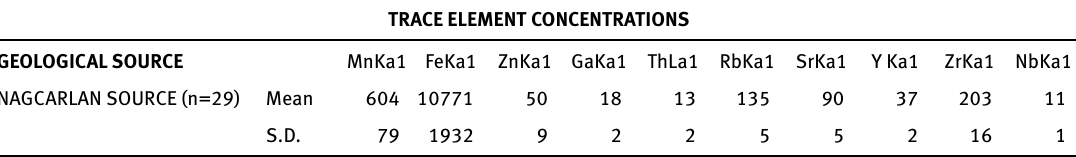
Table 3. Descriptive statistics of the geological source in the Philippines using